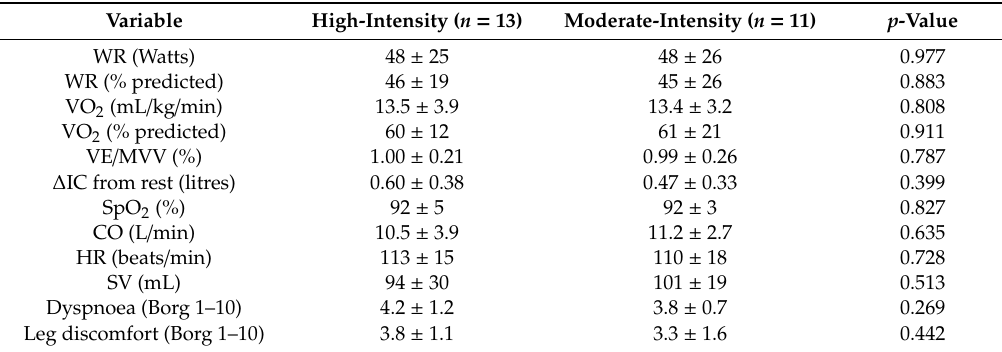
Table 2. Peak physiological variables at the limit of tolerance during cardiopulmonary exercise test (CPET).